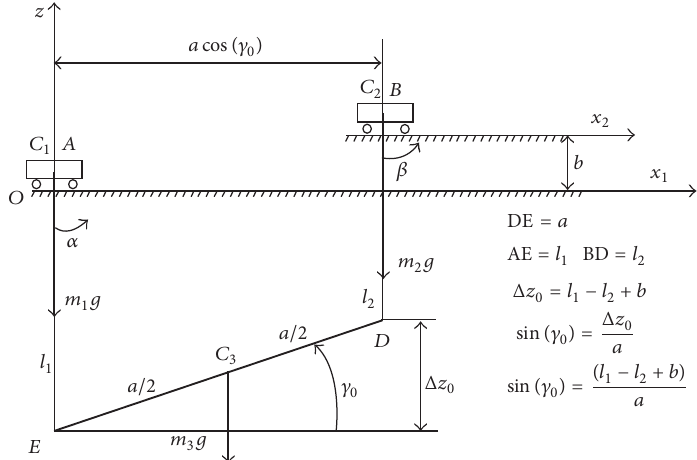
Figure 3: The computational scheme of the initial position of mechanical system during transportation of heavy cross-beam DE by two bridge cranes 𝐴 and 𝐵